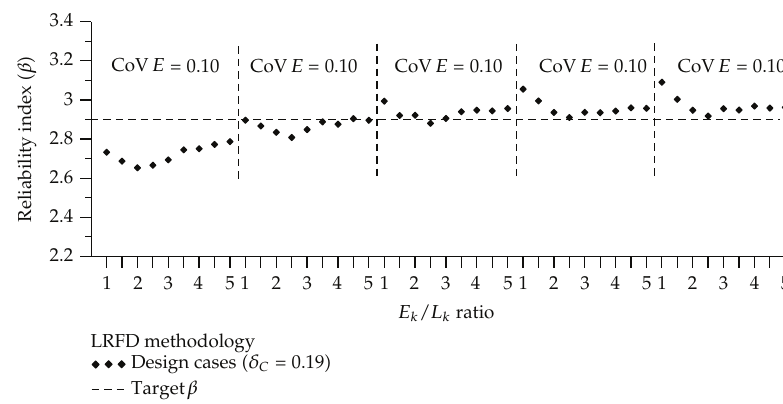
Figure 9: Reliability indexes of calibrated LRFD designs considering δ C (cid:8) 0 . 19 (cid:3) experimental tests (cid:4) .